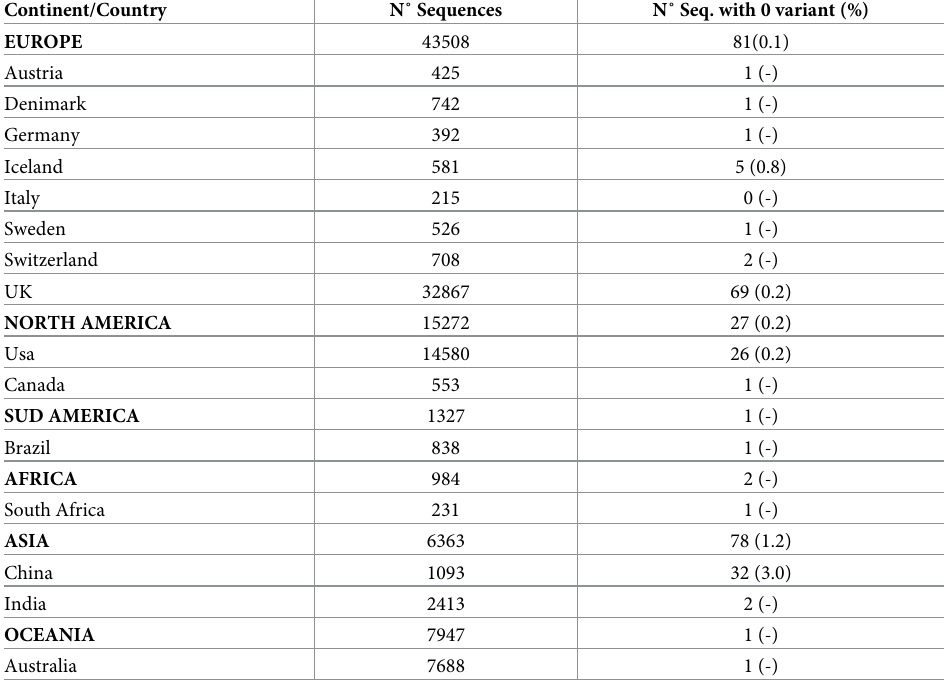
Table 1. SARS-CoV-2 sequence distribution. Continent/Country N˚ Sequences N˚ Seq. with 0 variant